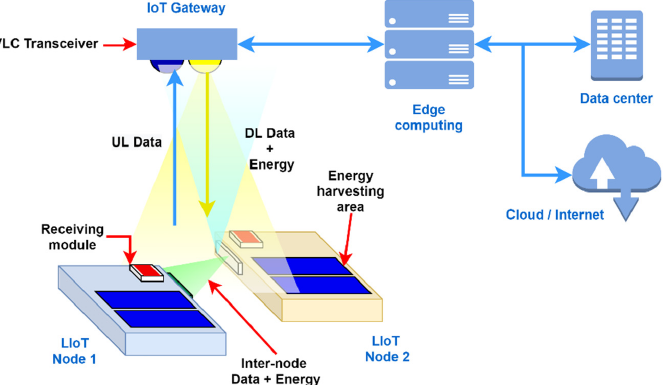
Figure 1. The light-based IoT concept and architecture: example of two networked LIoT nodes.